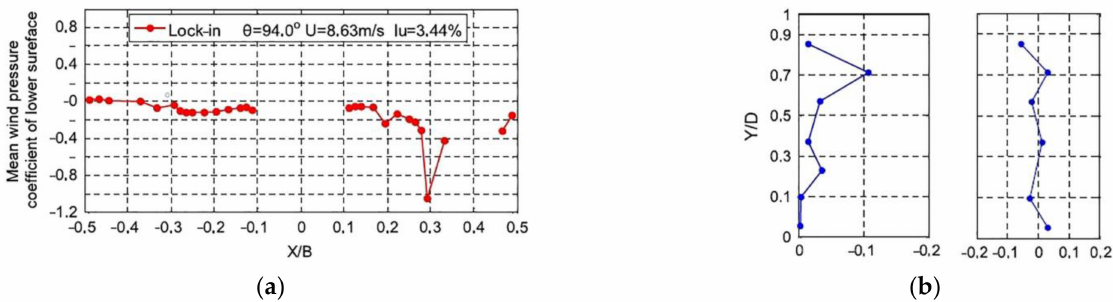
Figure 14. The average pressure distribution within 10 min in the lock-in range of vortex-induced vibration of the S1 section in the document [26]. ( a ) Pressure distribution on section S1 of the main beam; ( b ) Vertical pressure distribution of the upstream and downstream sections of the middle groove.